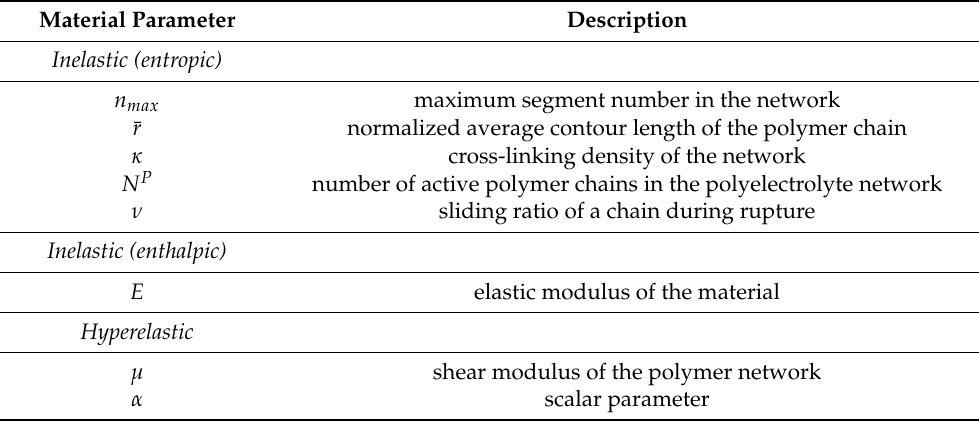
Table 1. List of material parameters and their description.